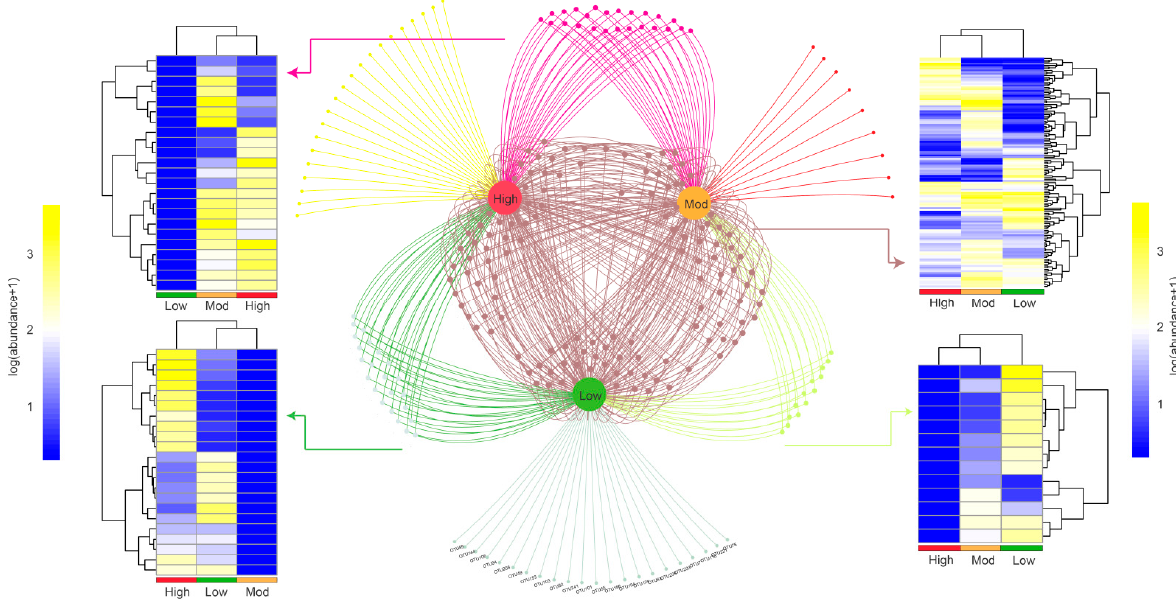
Figure 4. OTUs association network showing interactions between different treatments. The nodes represent OTUs shared or specialized by low, moderate, and high moso bamboo invasions . Heatmap showing the clustering patterns and abundances of OTUs identified in the three